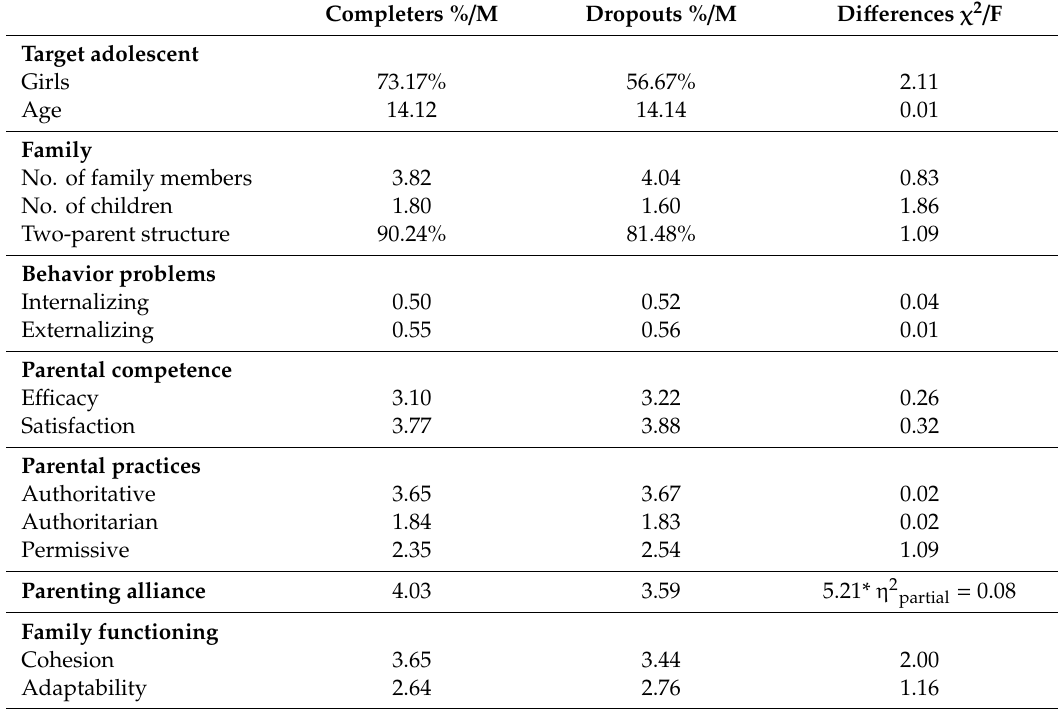
Table 1. Baseline characteristics for completers and